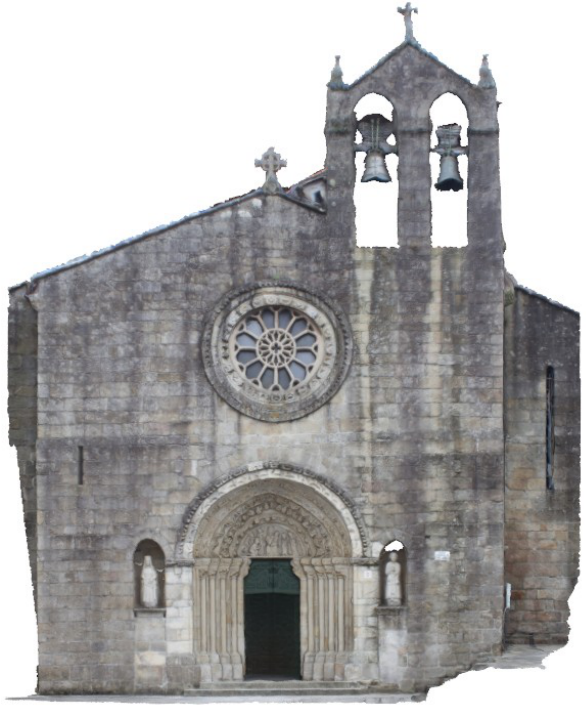
Figure 15. Orthoimage of the Textured Model obtained by projecting photos on the DSM.